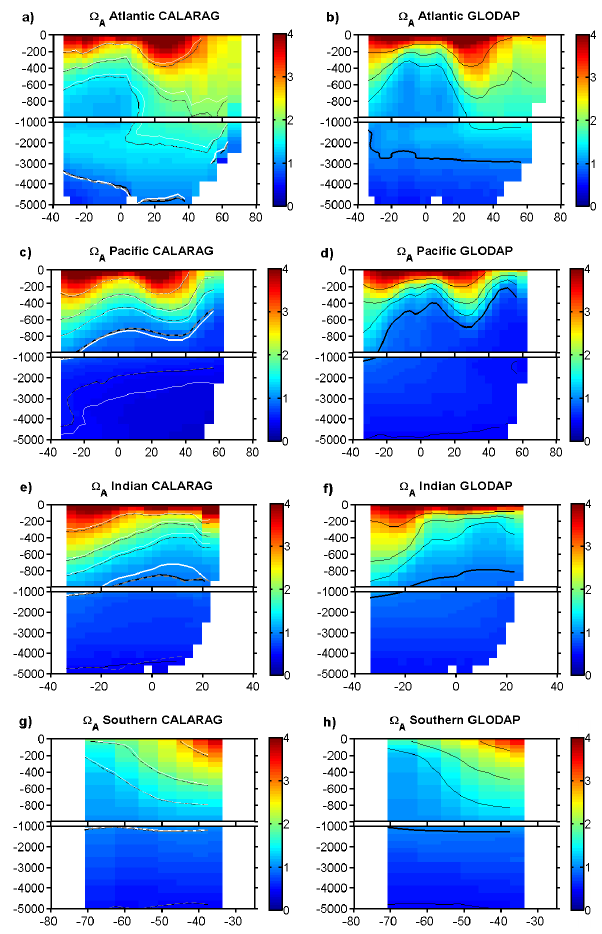
Fig. 10. Distribution of the aragonite saturation state simulated by the Bern3D/PISCES model (left; version CALMIC1) and based on observations from GLODAP (right). The saturation horizon in (a) , (c) , (e) and (g) is given for the CaCO 3 production parameteriza- tions CALMIC1 (white, calcite only), CALARAG (black, calcite and aragonite production) and CAL2ARAG (grey, calcite by both nanophyto- and mesozooplankton and aragonite). Values represent zonal